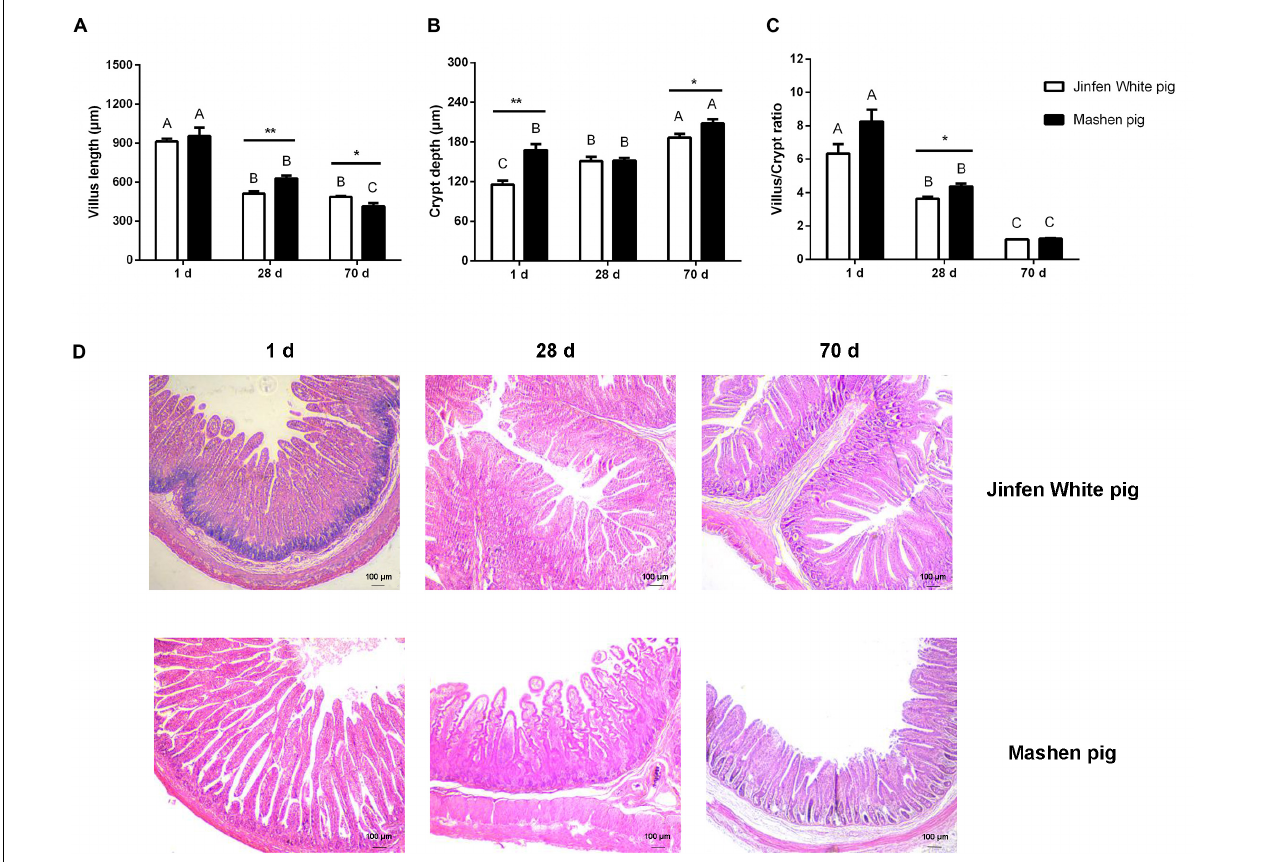
FIGURE 1 | The intestinal morphology of Jinfen White and Mashen piglets. (A) The villus height ( µ m), (B) crypt depth ( µ m), (C) villus/crypt ratio, and (D) ileum intestinal biopsy of Jinfen White and Mashen piglets (200 × ). One day, newborn; 28 days, weaning stage; and 70 days, end of nursey stage. Differences between two pig breeds were analyzed using Student’s t -test, * P < 0.05 and ** P < 0.01 indicate significant difference. Differences among different time points per breed were identified using ANOVA, values with the same or no letter superscripts mean no significant difference ( P > 0.05), while with different small letter superscripts mean significant difference at the level of 0.05, and with different capital letter superscripts mean significant difference at the level of 0.01.